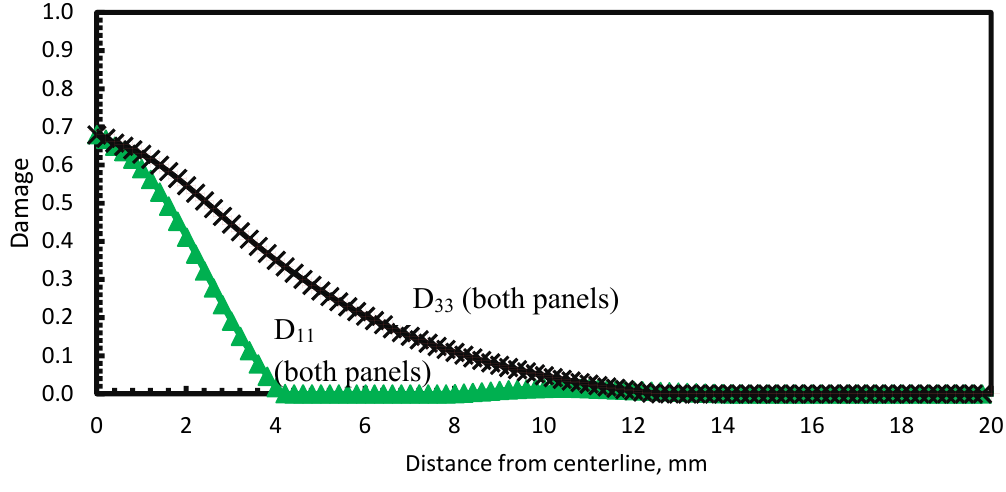
(web-shaped), D (star-shaped) 11 33